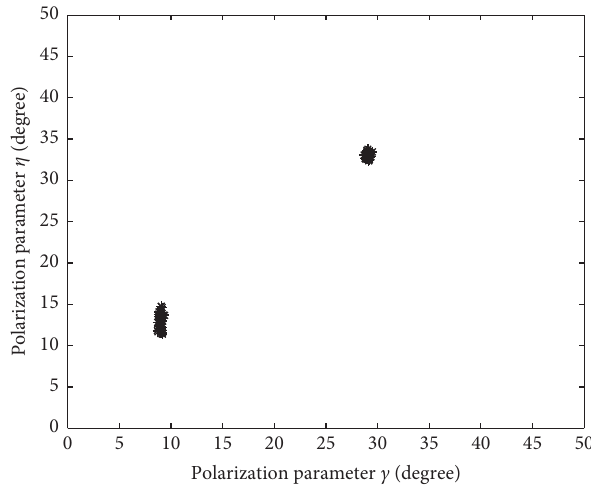
Figure 5: Scatter plot of polarization parameters c and η